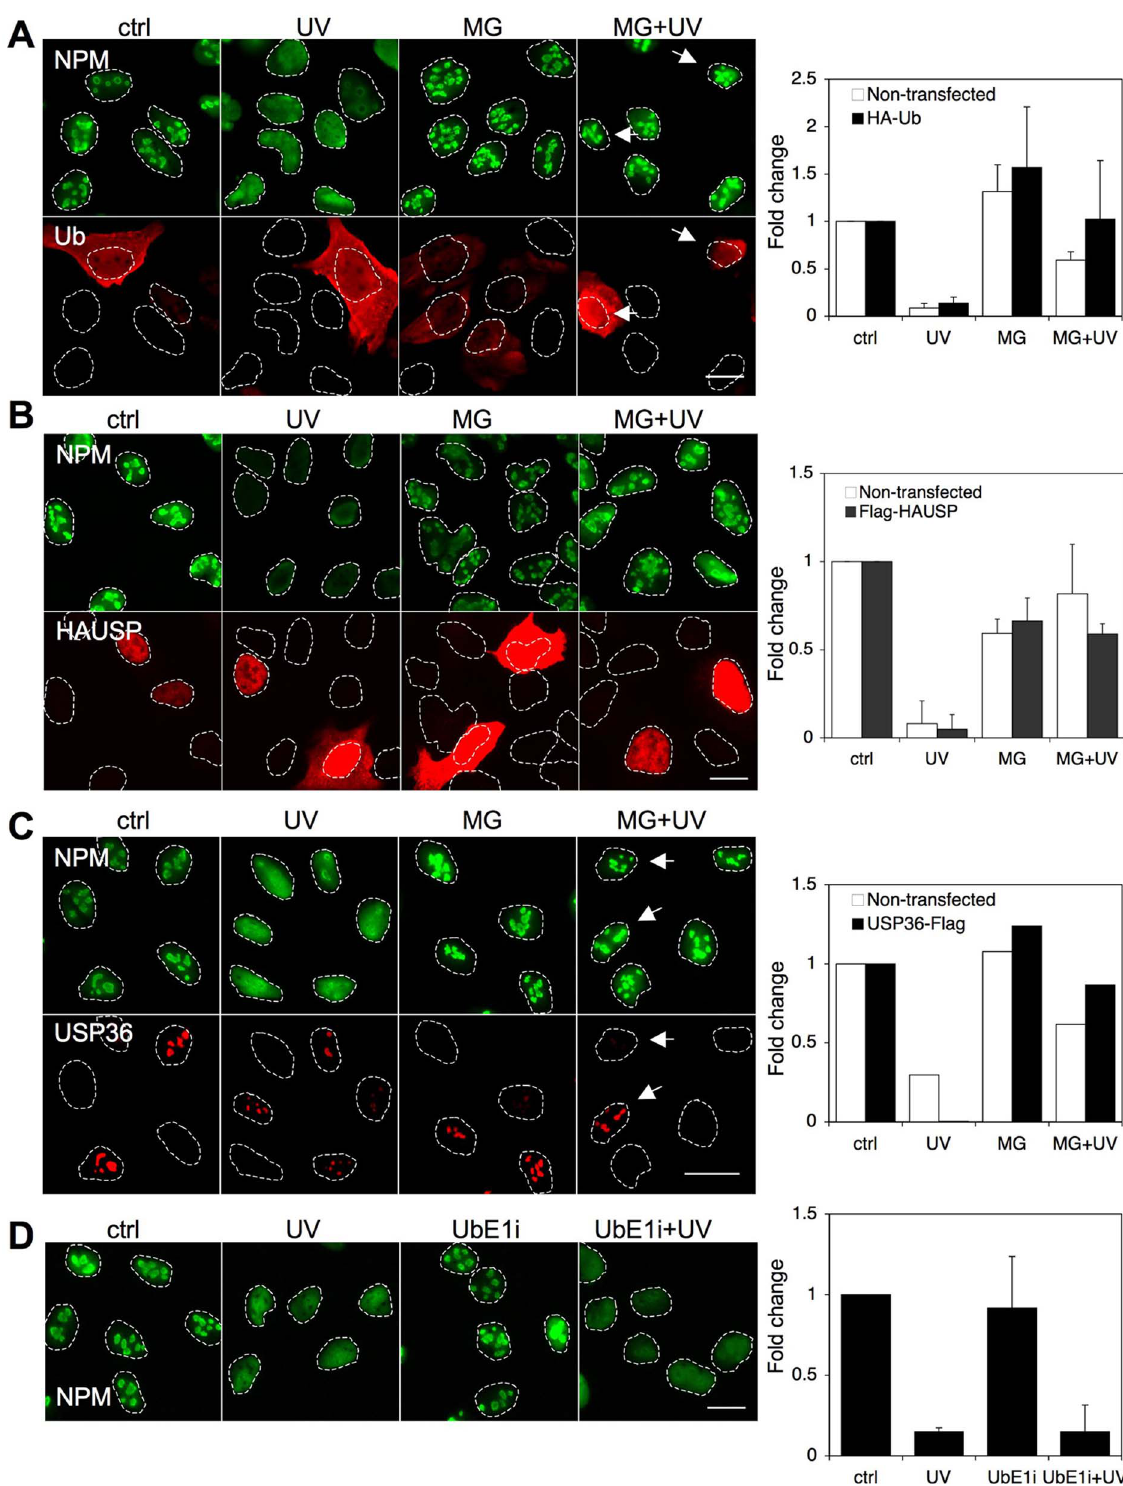
Figure 6. Ubiquitin recycling does not contribute to inhibition of NPM relocalization following UV radiation. U2OS cells were transfected with HA-tagged ubiquitin ( A ) or FLAG-tagged HAUSP ( B ). After 24 hours the cells were pretreated with MG132 followed by UV (35 J/m 2 ) as shown and the cells were incubated for 6 hours. Cells were fixed and the expressed proteins were detected using HA- ( A ) or FLAG ( B ) -antibodies and co-stained for NPM. Nucleolar areas were quantified from three independent experiments. C U2OS cells stably expressing USP36-Flag were pretreated with MG132 followed by UV (35 J/m 2 ) as shown and the cells were incubated for 3 hours. Cells were fixed and USP36 was detected using FLAG-antibody and cells were co-stained for NPM. Nucleolar areas were quantified. D U2OS cells were treated with UbE1 inhibitor (10 m M) or left untreated. After 24 hours the cells were exposed to UV (35 J/m 2 ) and incubated for 3 hours. Cells were fixed and stained for NPM. Nucleolar areas were quantified from two independent experiments. Scale bars 20 m m. doi:10.1371/journal.pone.0059096.g006 PLOS ONE |